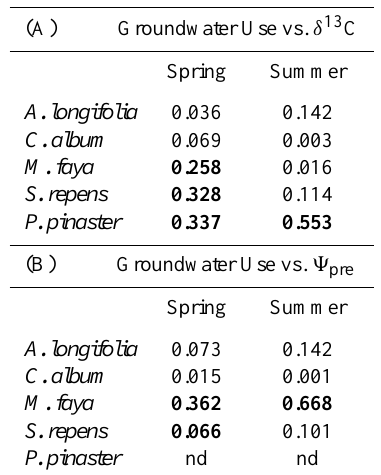
Table 2. Regression coefficients ( R 2 ) for the dependence between groundwater use and (A) bulk leaf δ 13 C and (B) predawn xylem wa- ter potential ( 9 pre ) in spring and summer. Significant regressions ( α = 0 . 05) are in